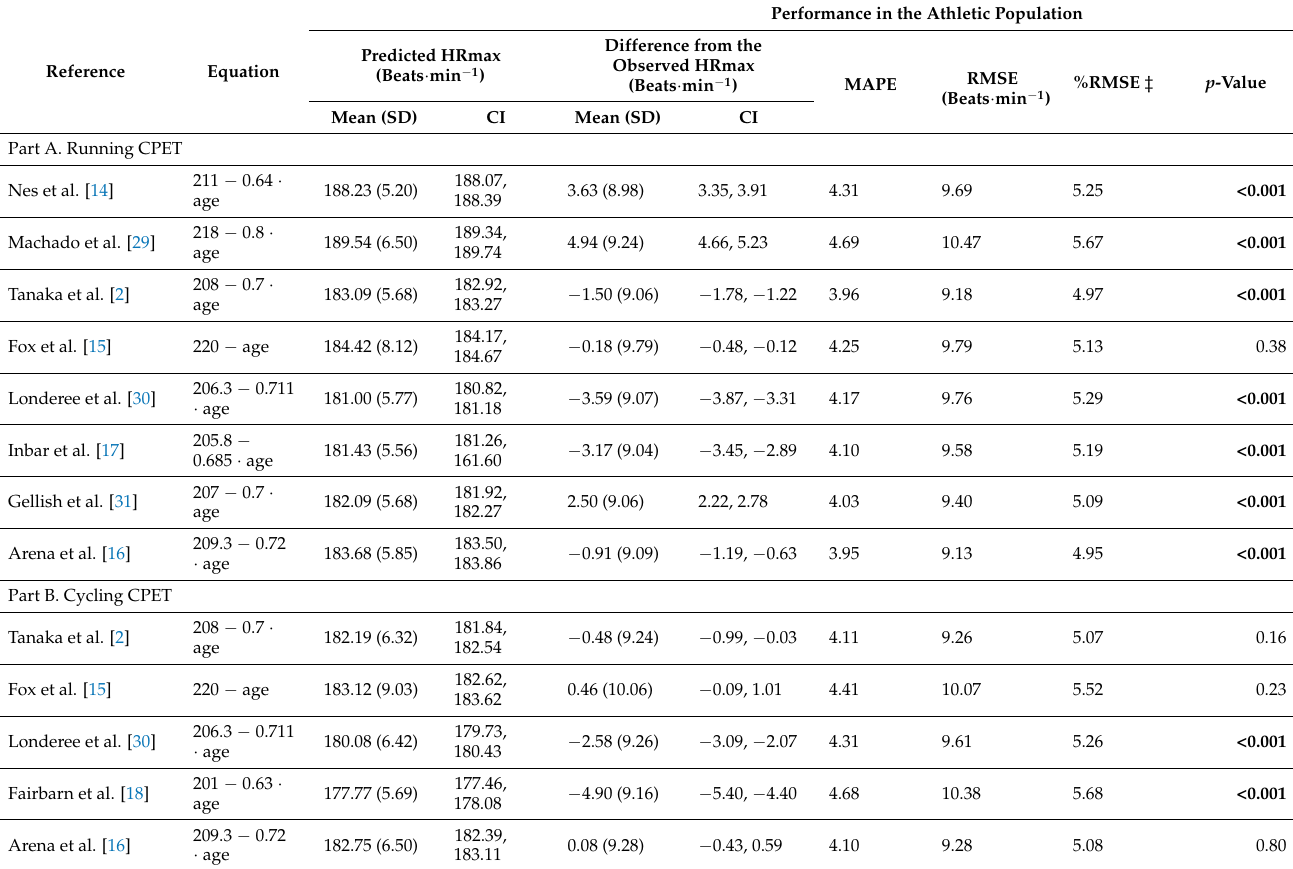
Table 2. Comparison of performance of selected HRmax prediction